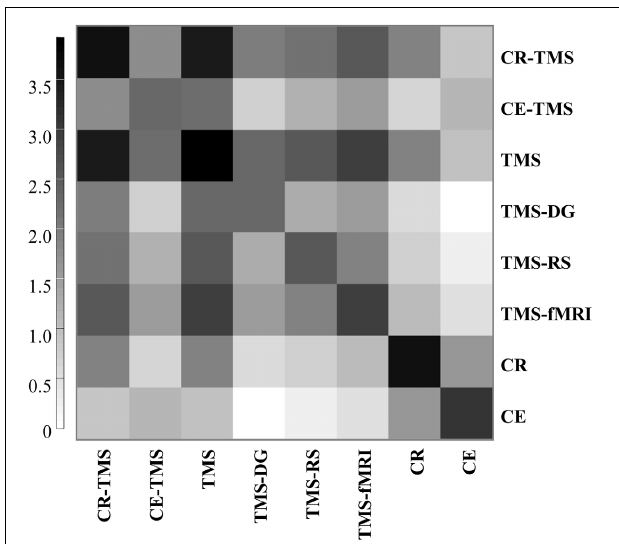
FIGURE 4 | Number of common publications (in decimal logarithmic scale) for pairs of corpora representing topics labeling the rows and the columns of the matrix. Different shades of gray (see the color-coding bar) represent different powers of